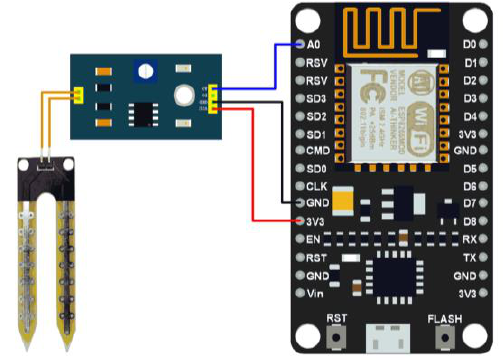
Figure 10. YL-69 wiring diagram with ESP8266